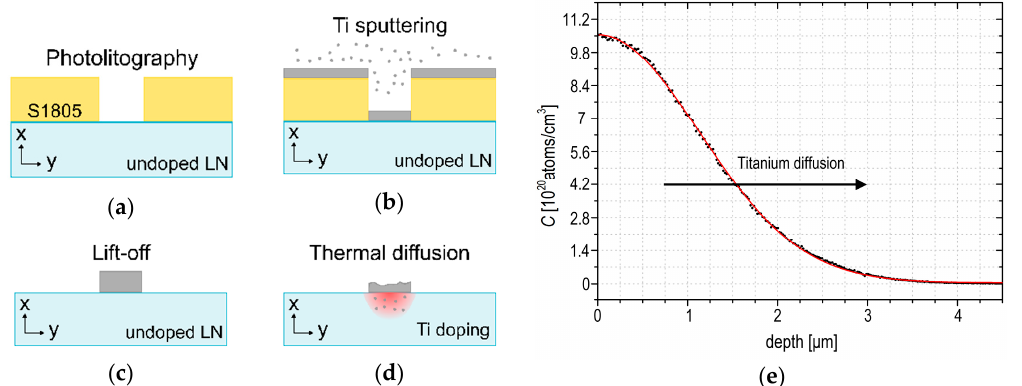
Figure 1. Titanium diffused channel waveguide fabrication on a commercial x-cut lithium niobate (LN) wafer. Sketches of the steps involved in the realization of the Ti-diffused waveguides, including ( a ) photolitography, ( b ) Ti deposition, ( c ) lift-off, ( d ) thermal diffusion. ( e ) The graph reports the profile of the titanium diffused inside x-cut lithium niobate, and the red line is a semi-gaussian interpolation of the data (black points) .